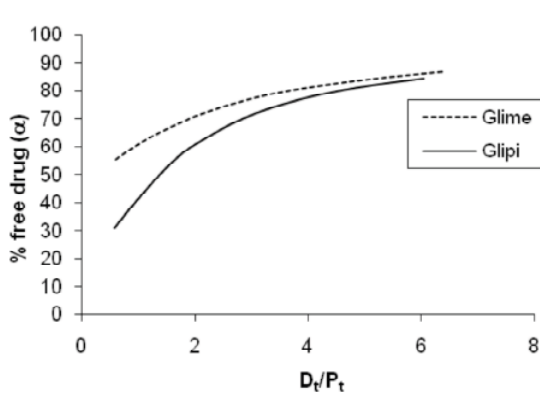
Figure 2. Percentage of free drug (37 0 C) at different drug:protein ratios.